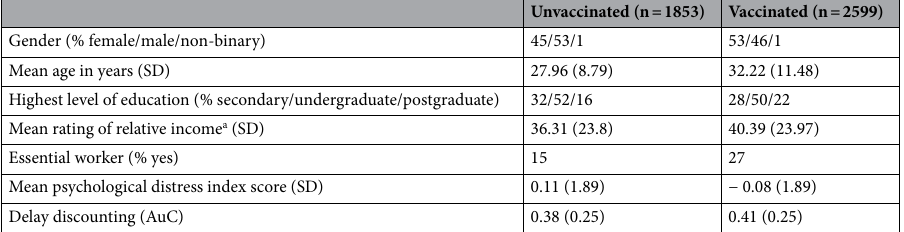
Table 1. Participant characteristics by vaccination status. a 100-point scale, where 0 = low, 50 = medium, and 100 = high relative to others in the participants’ country/region. AuC area-under-the-curve (range, 0–1), undergrad undergraduate degree or professional equivalent, postgrad postgraduate degree (e.g., Masters, PhD), SD standard deviation.